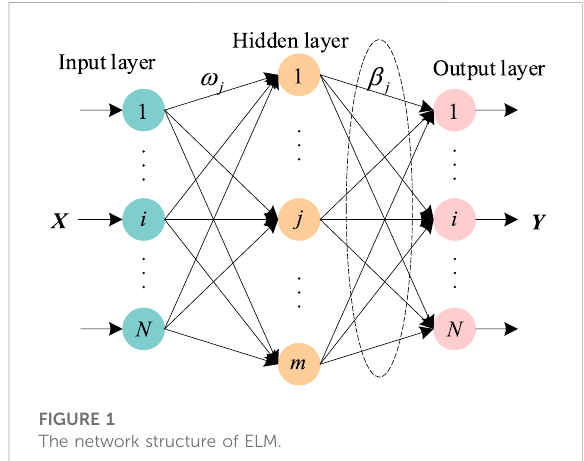
FIGURE 1 The network structure of